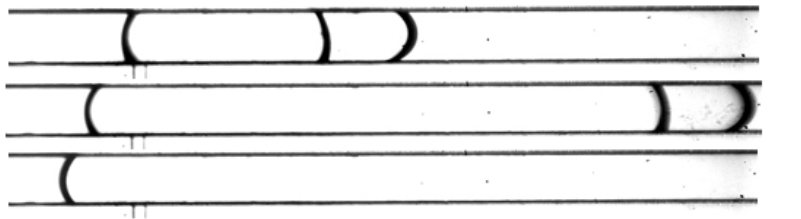
Figure 8. High-speed images of a convex liquid bridge: liquid is accumulated into the pore, forms a capillary, propagates, and splits into three convex plugs.